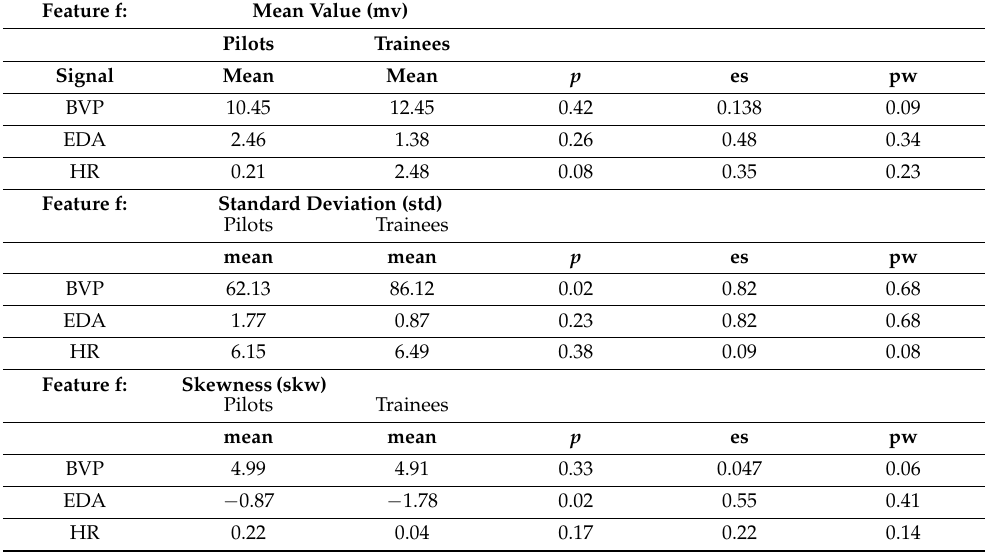
Table 4. Statistically extracted features: the standard deviation of the BVP and skewness of the EDA is significantly different in pilots as opposed to trainees. The differences with relatively high effect size and low post-hoc power indicate undetected differences between the internal features of groups of pilots and trainees, mean value (mv), standard deviation (std), and skewness (skw); affecting the intermediate features— p -value ( p ), effect size (es), and post hoc statistical power (pw). Feature